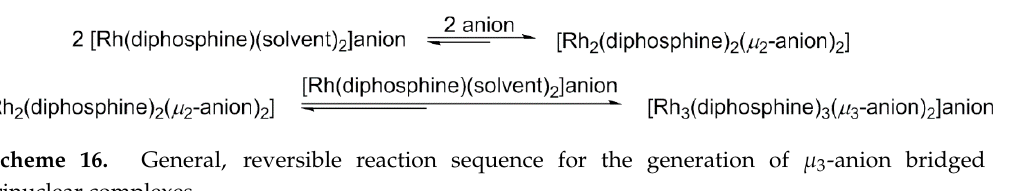
Figure 18. Molecular structure of the cation [Rh 3 (Me-DuPhos) 3 ( µ 3 -OMe) 2 ] + . Hydrogen atoms are omitted for clarity.